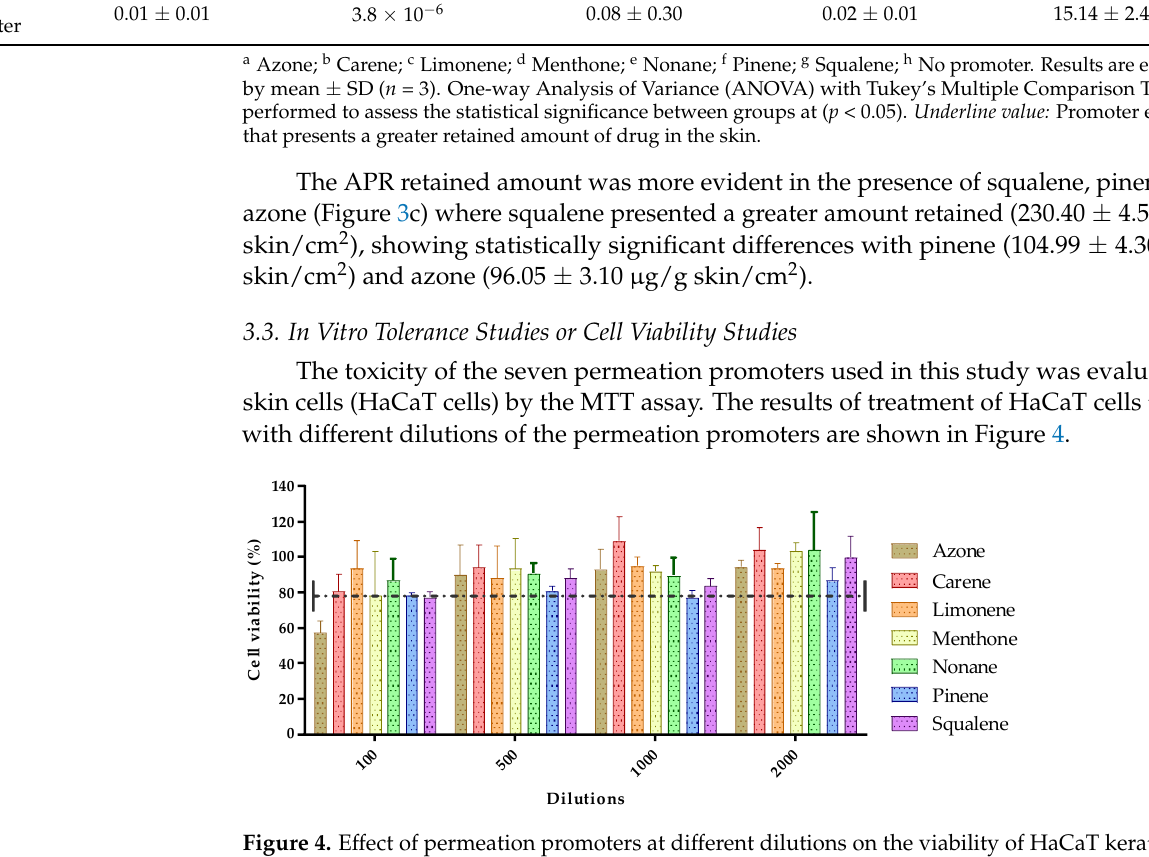
Figure 5. Stratum corneum hydration. p value: *** = p < 0.0001; ns = no significance . 3.4.2. Colorimetric Parameters The irritation potential of a solution containing APR and Squalene in its composition was evaluated. The irritation was measured through the color differences that appeared after the application of the solutions on the back of the rats ’ skin.